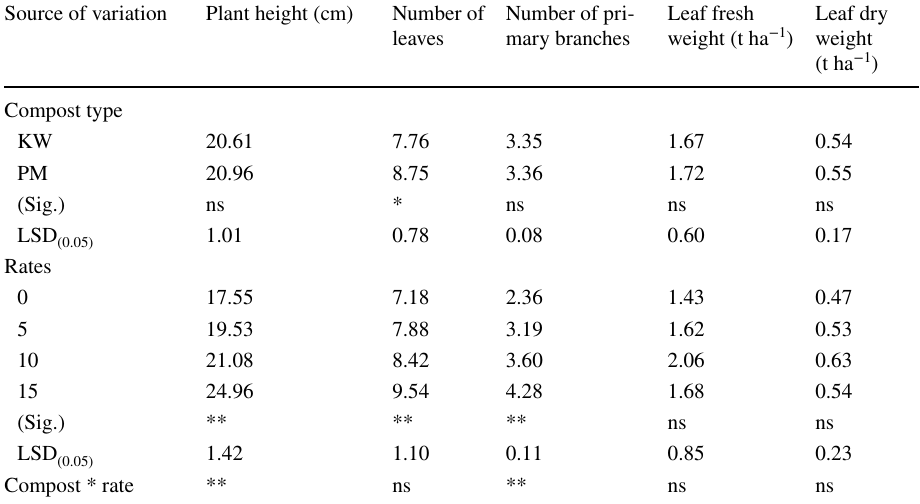
Table 3 Effects of compost types and their rates of application on growth and yield of Corchorus olitorius at